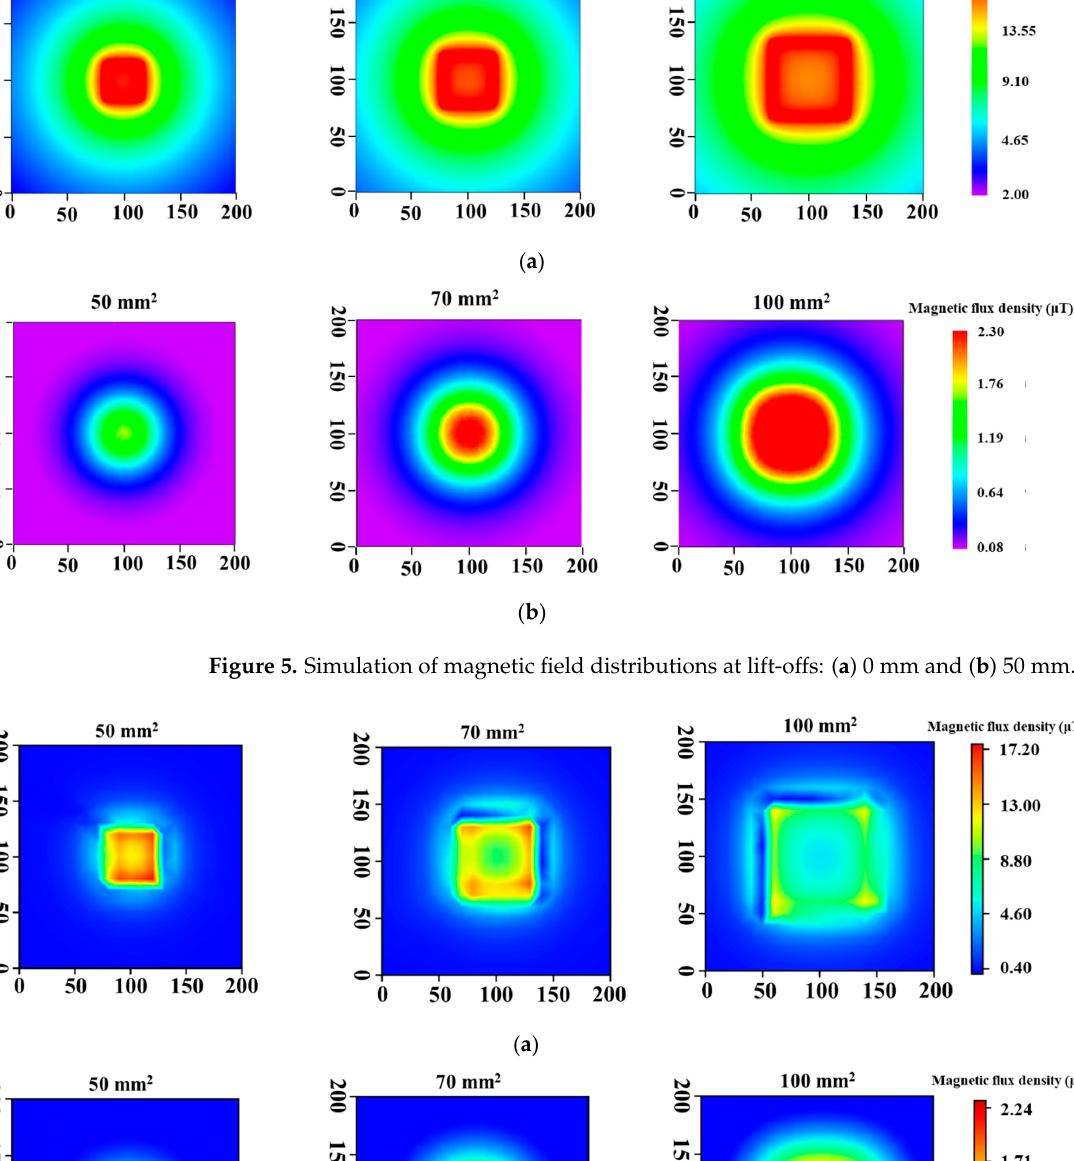
Figure 5. Simulation of magnetic field distributions at lift-offs: ( a ) 0 mm and ( b ) 50 mm. Figure 6 shows the magnetic field distributions measured with the prototype probes.